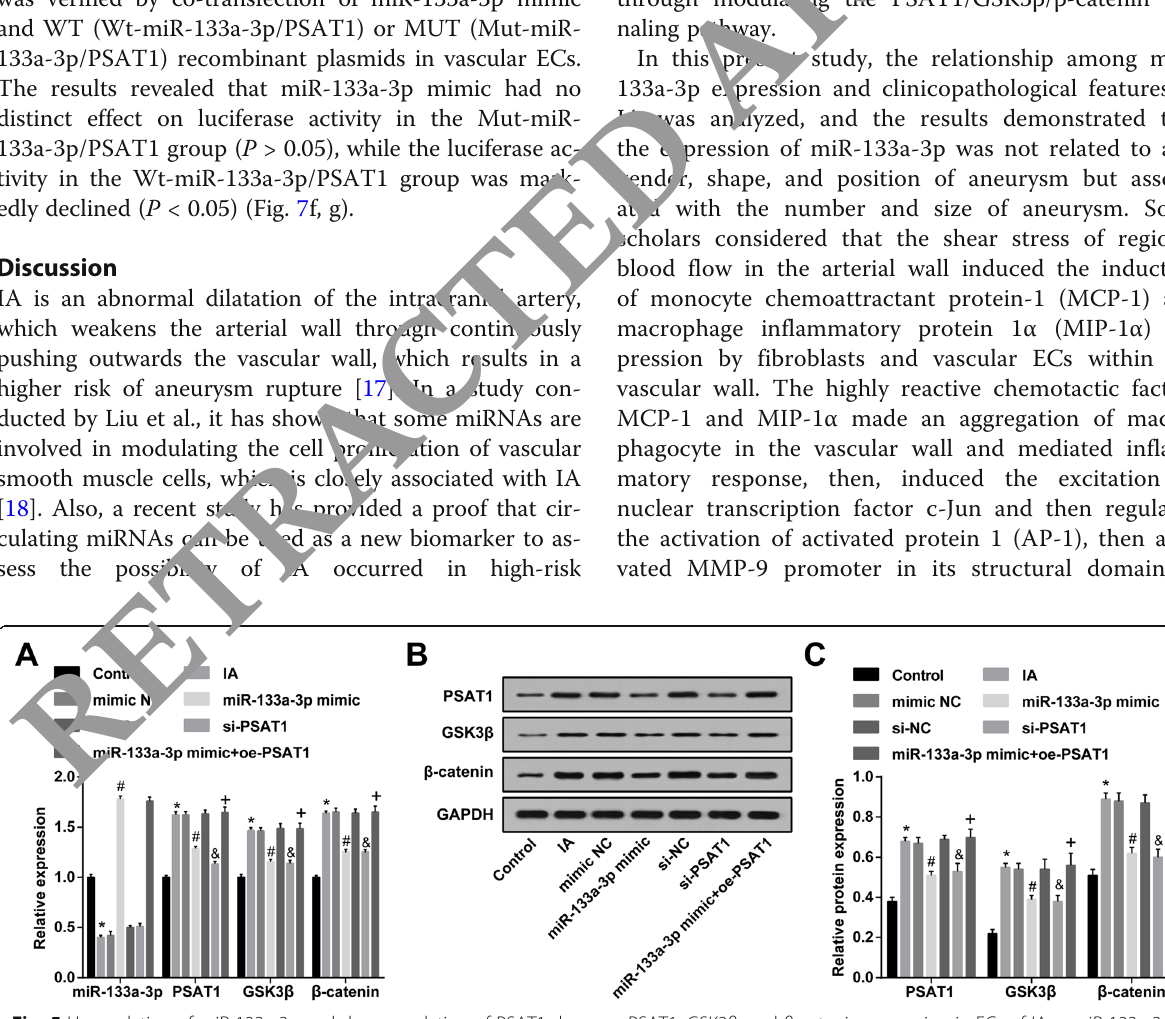
Fig. 5 Upregulation of miR-133a-3p and downregulation of PSAT1 decrease PSAT1, GSK3 β , and β -catenin expression in ECs of IA. a miR-133a-3p, PSAT1, GSK3 β , and β -catenin expression in ECs detected by RT-qPCR. b Protein bands of PSAT1, GSK3 β , and β -catenin. c PSAT1, GSK3 β , and β - catenin protein expression in ECs in each group detected by western blot analysis. N = 3, * P < 0.05 vs. the control group. # P < 0.05 vs. the mimic NC group. & P < 0.05 vs. the si-NC group. + P < 0.05 vs. the miR-133a-3p mimic group. Measurement data were depicted as mean ± standard deviation, and data were assessed by one-way analysis of variance followed by Tukey ’ s post hoc